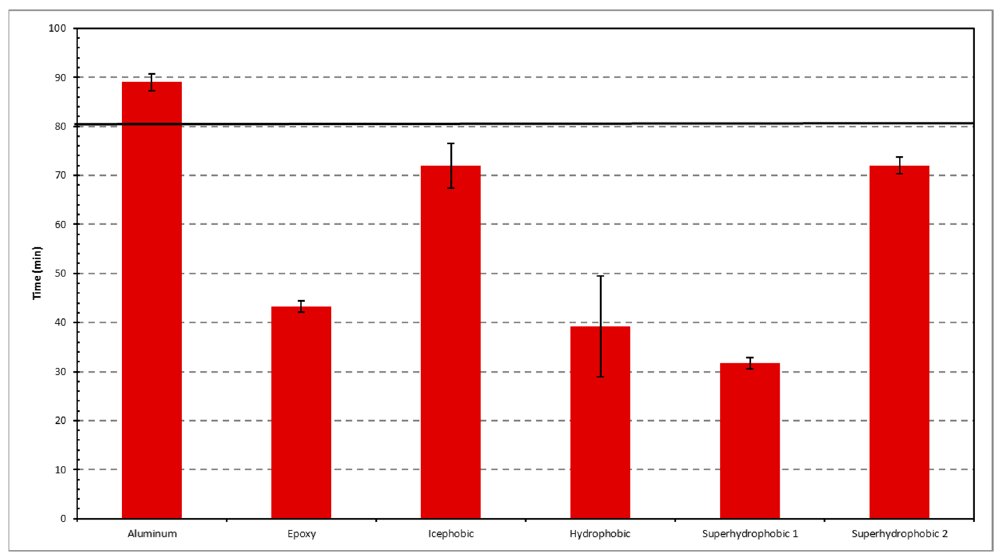
Figure 12. Endurance time for the different surfaces for Fluid B. Bold black line at 80 min is the minimum requirement as per AMS1428 [9].